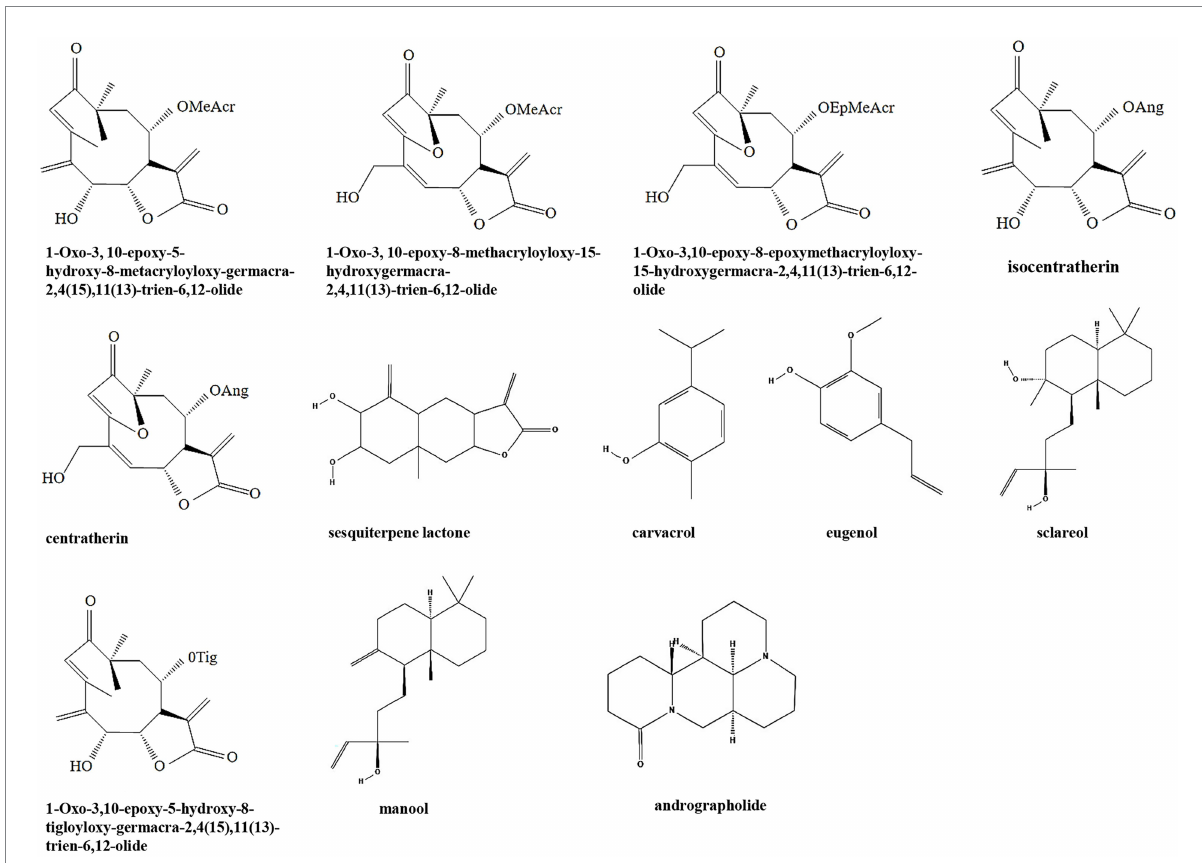
FIGURE 3 Chemical structures of the different terpenoids that inhibit biofilm formation via QS. ChemDraw software has been utilized to draw the chemical structures of the